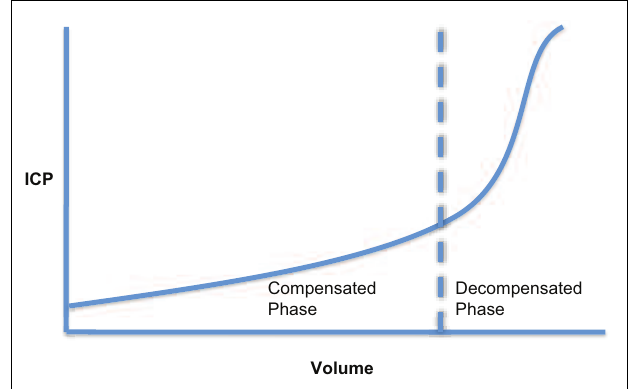
FIGURE 2 | Cerebral volume–pressure curve showing the exponential relationship between ICP and an increase in volume of one of the intracranial components .